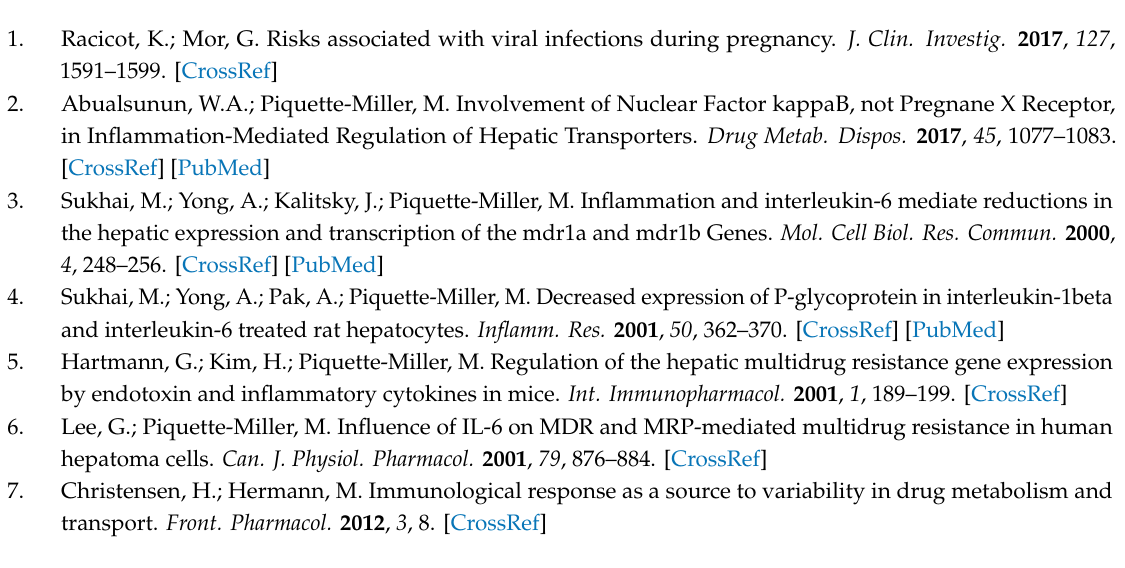
Figure S1: E ff ect of poly I:C on renal mRNA expression of transporters at 48 h. mRNA was extracted from kidneys at 48 h after i.p. administration of 10 mg / kg poly I:C or saline to pregnant rats on gestational day 14 as described in methods ( n = 8 / group). Results are expressed relative to saline control and shown as mean ± S.E.M. Significance was determined using the Student’s Unpaired t -Test., Figure S2. E ff ect of poly I:C on protein expression of transporters. Representative western blot images at (A) 24 h and (B) 48 h after i.p. administration of 10 mg / kg poly I:C or saline to pregnant rats on gestational day 14 as described in methods ( n = 8 / group). Table S1: